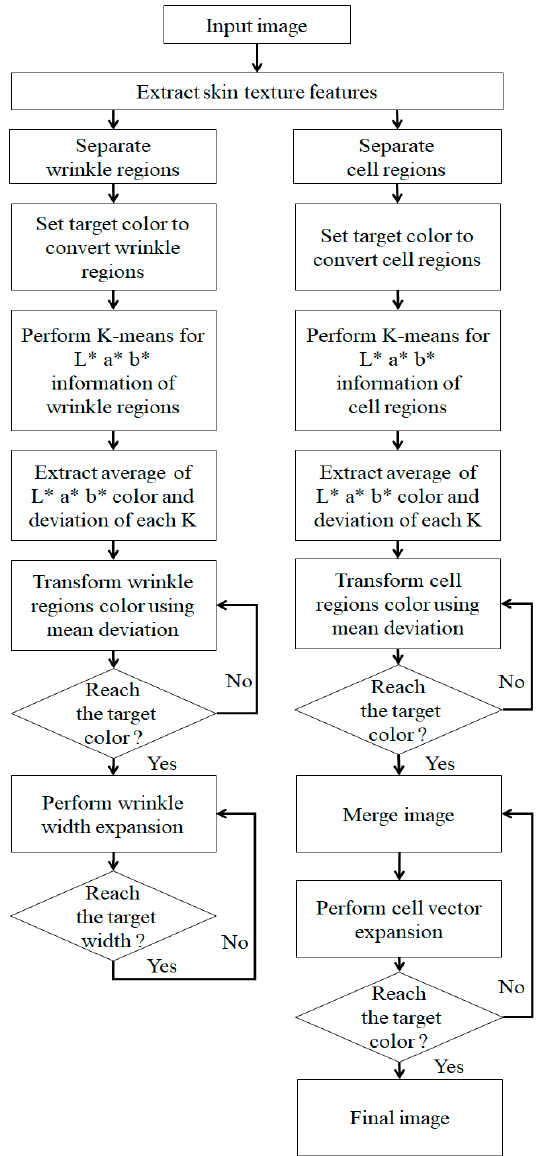
Figure 3. Flowchart of skin aging simulation.